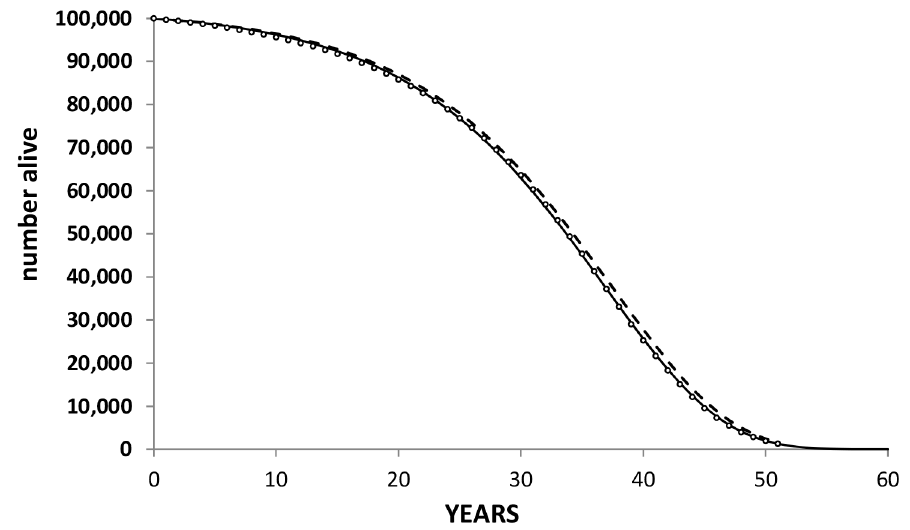
Figure 3. Gompertz fit to the ONS data. Symbols represent the UK ONS survival for 50 year old individuals; the solid line is a Gompertz fit to the ONS data; the dashed line represents the survival of aspirin users based on a ten year OR for all-cause mortality of 0.94 (Seshasai [38] & Berger [19]) and modelled keeping the scale parameter for the Gompertz fit constant. The difference in area under the solid and dashed curves represents the mean gain in life over a life time horizon. doi: